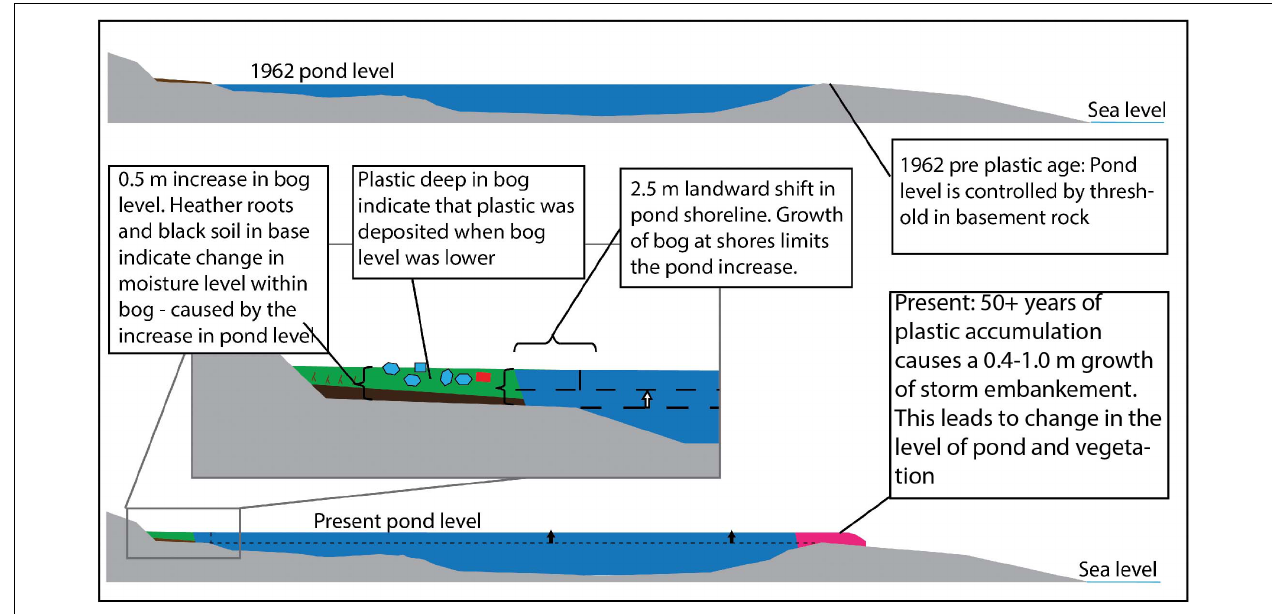
FIGURE 10 | Model displaying the evolution of the Lisle Lyngøyna from the onset of plastic in the 1960s. See insets and text for explanation.